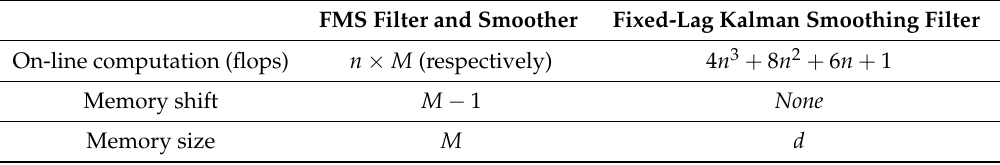
Table 1. Comparison of on-line computation and memory